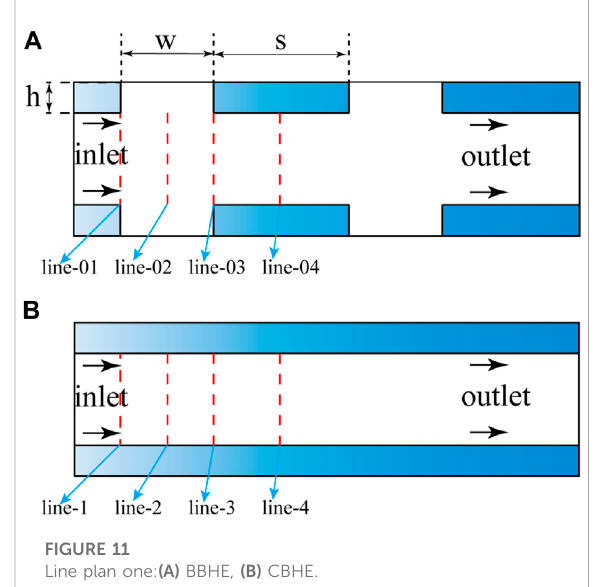
FIGURE 11 Line plan one: (A) BBHE, (B) CBHE.